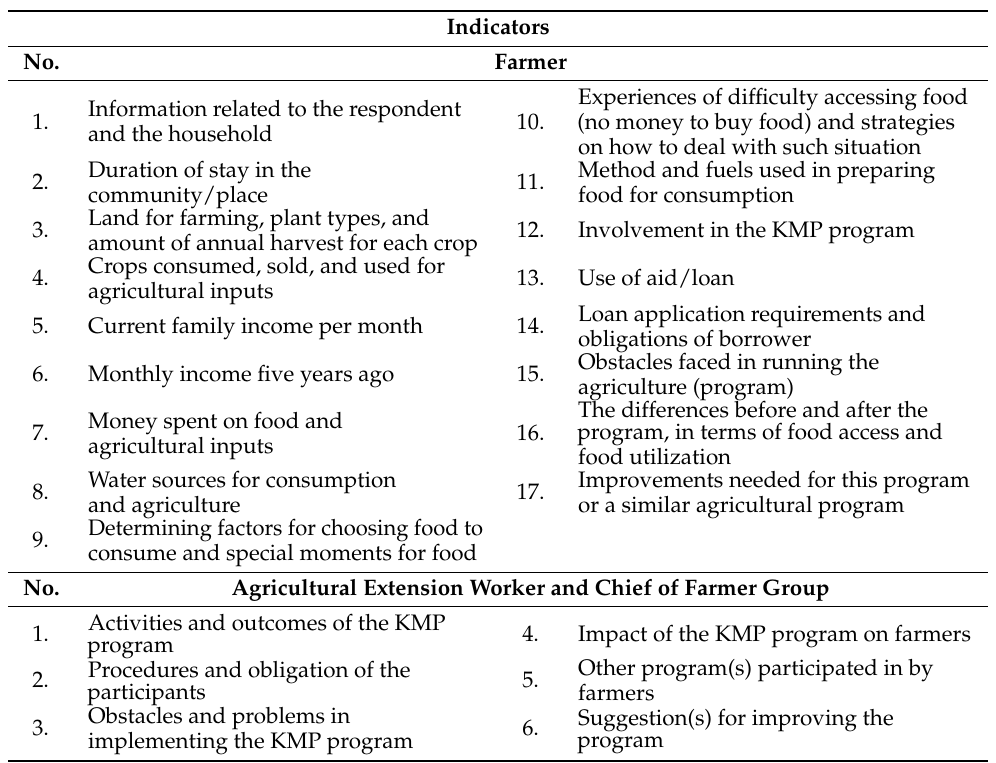
Table 1. Indicators used during interviews and FGD sessions.